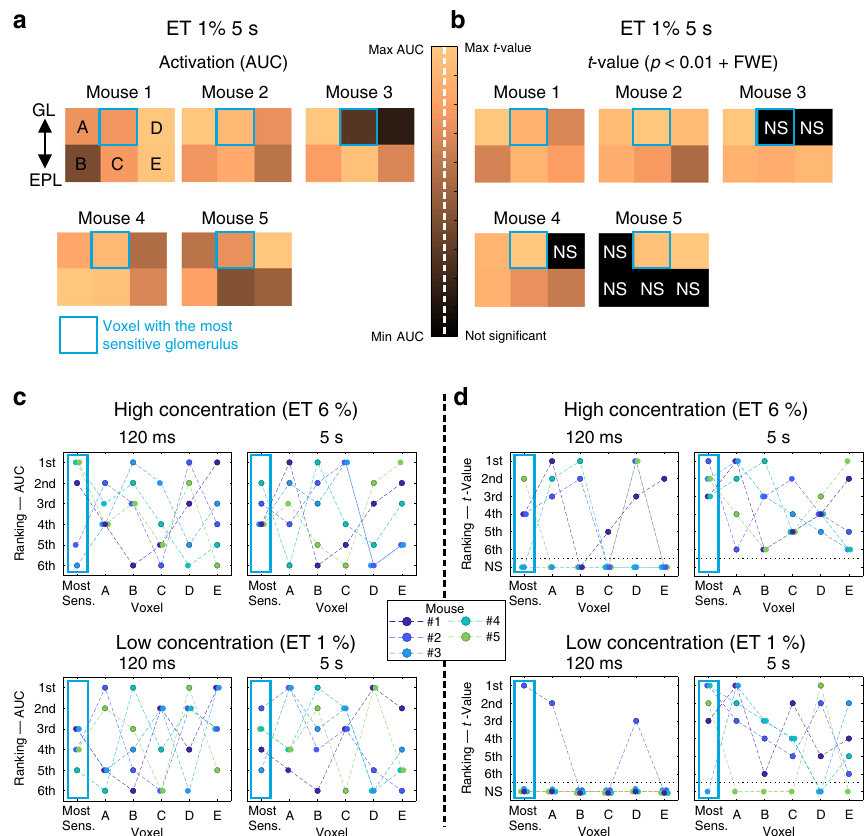
Fig. 5 Spatial resolution of fUS responses. a Quanti fi cation of fUS responses (area under the curve, ET 1%, 5 s) in the voxel containing the most sensitive glomerulus (outlined with a blue frame) and the fi ve neighboring voxels (A – E, n = 5 mice, GL glomerular layer, EPL external plexiform layer). The color map shows that only in one case, the largest response was located in the blue voxel. The color bar was scaled with respect to the highest AUC value across the six voxels. b Statistical analysis (GLM) of fUS responses in the corresponding voxels using the RBC velocity response (CBV fl owing at 0.5 – 1.5 mm s − 1 ) as a regressor. The t value for the voxel containing the most sensitive glomerulus was not systematically the highest one. The applied statistical threshold was p < 0.01 + FWE correction. NS for not signi fi cant. c Quanti fi cation of fUS responses (AUC) for four stimulation conditions. For the fi ve mice, the voxel containing the most sensitive glomerulus and the other fi ve voxels were ranked with the 1 st place assigned to the voxel with the highest AUC value. d Statistical quanti fi cation of fUS responses with ranking based on t values. The 1 st place was assigned to the highest t value. Source data are provided as a Source Data fi